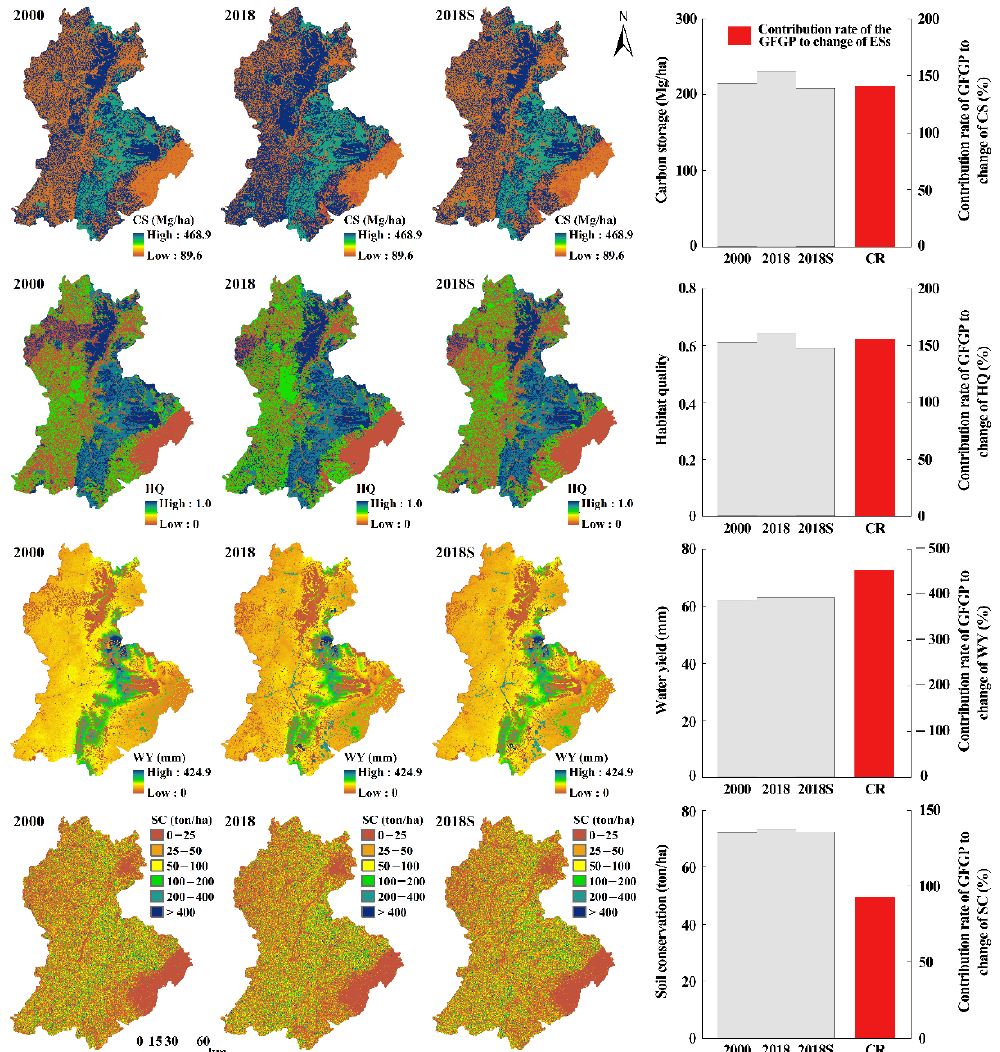
Figure 3. Spatial pattern of ESs in 2000, 2018, and 2018S. 2018S: the scenario if the GFGP were not implemented. The bar chart on the right represents the average value of ESs in 2000, 2018, and 2018S and the contribution rate of the GFGP to the changes in ESs. Abbreviations: CS: carbon storage; WY: water yield; SC: soil conservation; HQ: habitat quality. Table 4. Pearson’s correlation analysis between changes in ecosystem